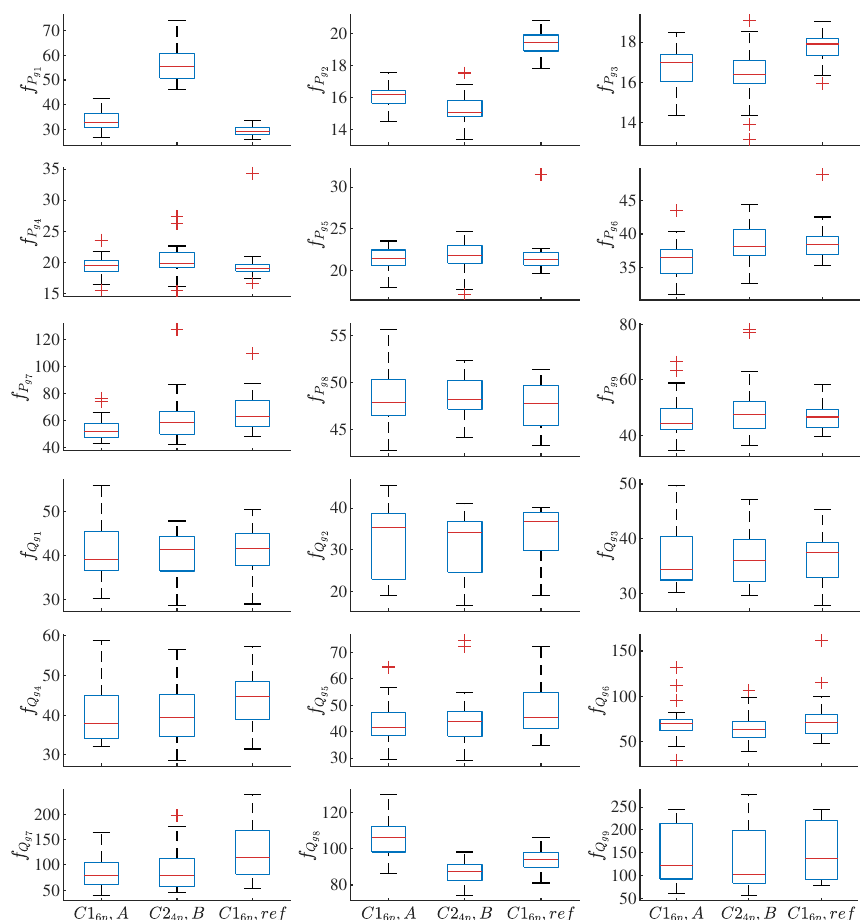
Figure 13. Comparison, for each performance index, of the boxplots representing the data points collected experimentally for the three parameter sets